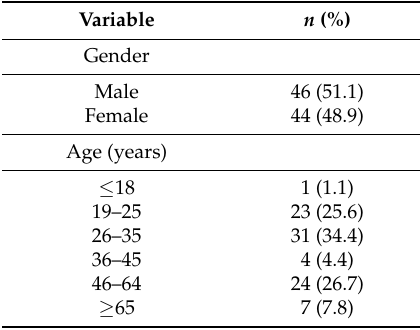
Table 2. Demographic information of the participants ( n = 90).